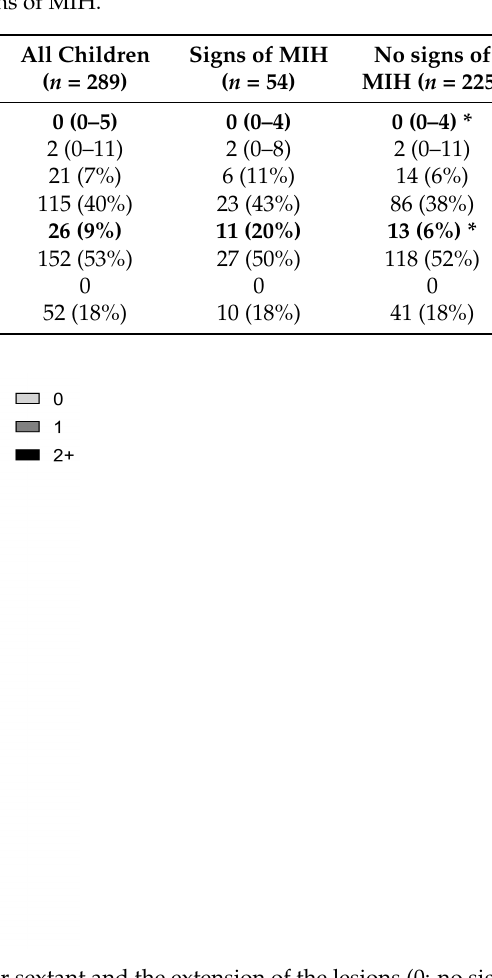
Table 1. Outcomes related to dental caries experience in the whole sample and specific for children showing signs of MIH vs. not showing signs. Data in bold and marked with * are significantly different between children with or without signs of MIH.